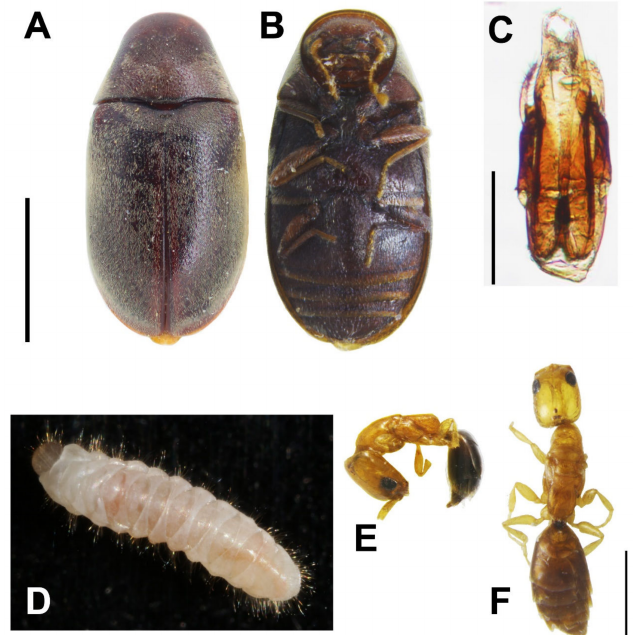
Figure 2. Falsogastallus sauteri . ( A ) Adult habitus, dorsal view and ( B ) ventral view (scale = 1 mm). ( C ) Male genitalia (scale = 0.2 mm). ( D ) Larva habitus, dorsal view. ( E , F ) Cephalonomia formosiensis sp. nov. ( E ) Habitus of brachypterous adult female, lateral view and ( F ) dorsal view (scale = 0.2